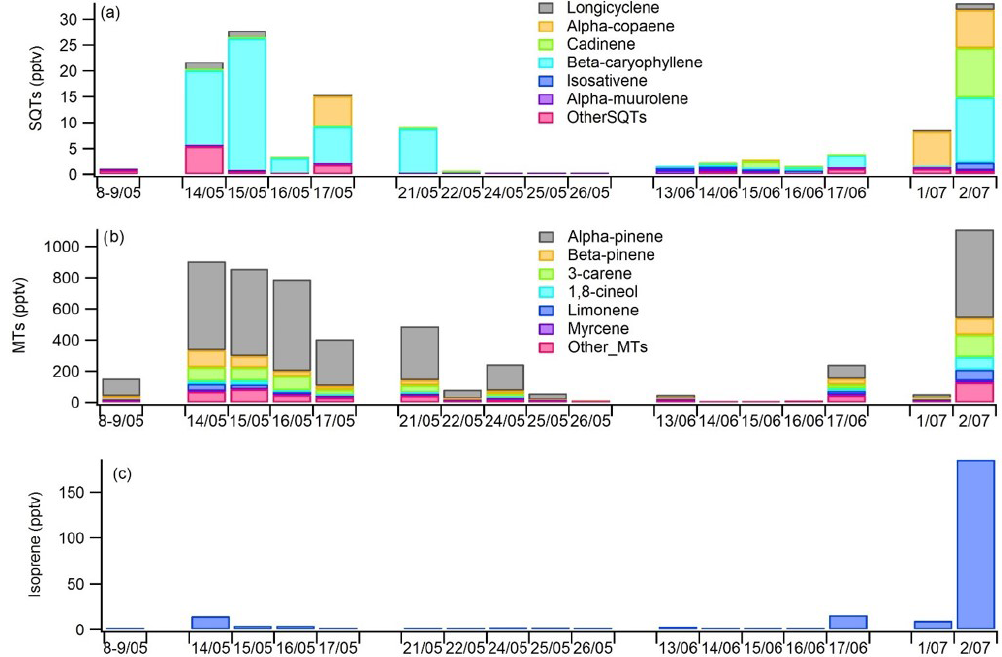
Figure 9. Daily mean concentrations of (a) sesquiterpenes (SQTs), (b) monoterpenes (MTs) and (c) isoprene in the ambient air at Lompolo- jänkkä fen in 2018.